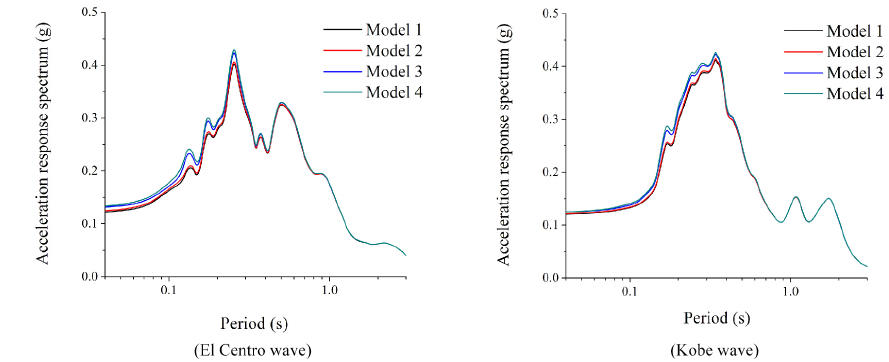
Figure 4. Acceleration response spectrum of point A of four free-field models in the form of P-wave input.